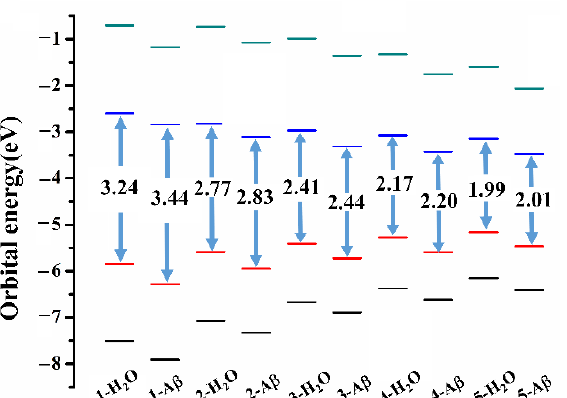
Figure 5. The energy levels of the molecular frontier orbitals and energy gap for probes 1–5 in different microenvironments.